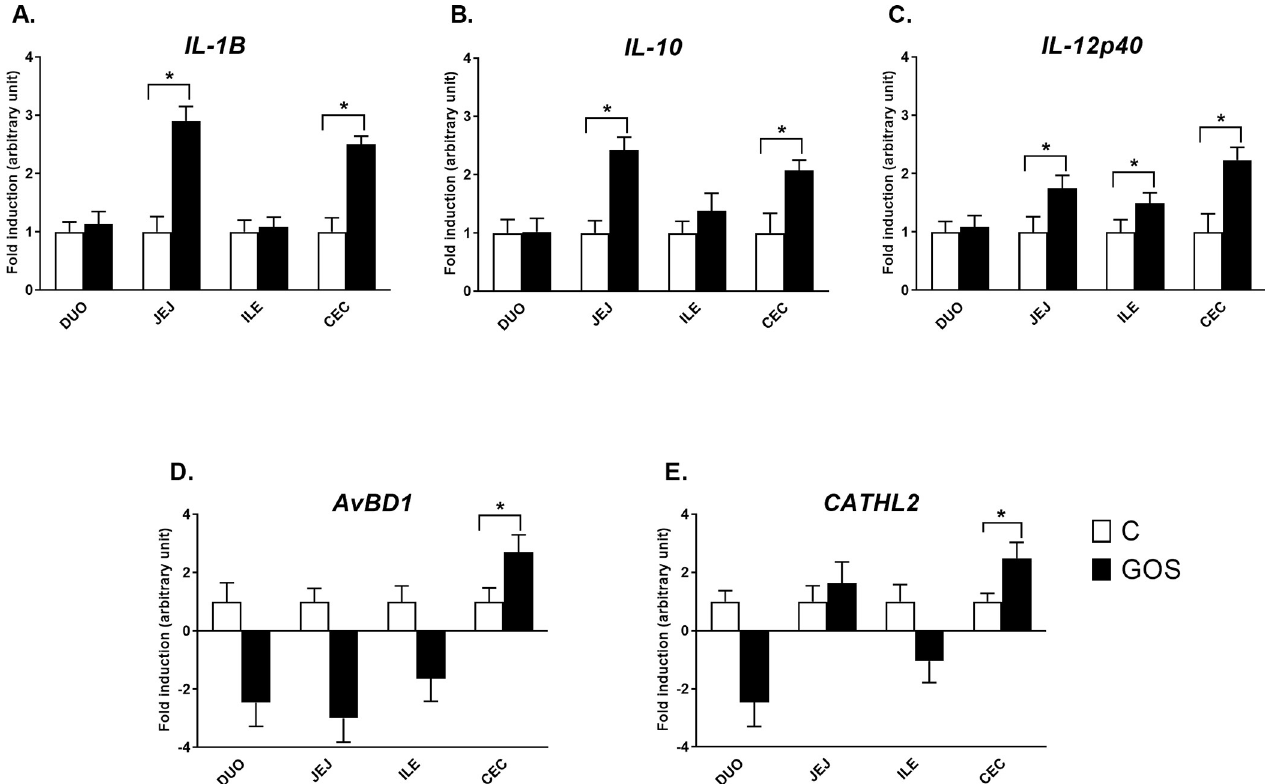
Fig 3. Relative mRNA expression of intestinal immune-related genes in different segments of intestinal mucosa in chickens injected in ovo with GOS. The panel includes genes encoding cytokines, (A) IL-1 β , (B) IL10 and (C) IL12p40 ; and host defence peptides, (D) AvBD1 and (E) CATHL . Intestinal segments: DUO–duodenum, JEJ–jejunum, ILE–ileum, and CEC–caecum. In ovo treatment groups: control (white bars), injected in ovo with physiological saline; GOS (black bars)–injected in ovo with galactooligosaccharides. In ovo injection was carried out on day 12 of egg incubation. Intestinal samples (n = 10) were collected from chickens on day 42 post-hatching. RT-qPCR data were generated with custom-designed primers used for amplification with SYBR green dye; Glucose-6-phosphate dehydrogenase ( G6PDH ) and beta-actin ( ACTB ) were used as reference genes; relative gene expression calculated as 2 – ΔΔ Ct; Two-way ANOVA with post hoc HSD Tukey test was used to compare the groups. Asterisk indicates pair-wise significant differences ( P < 0.05). The results of fold induction less than 1 have been transformed by the formula -1/fold induction.